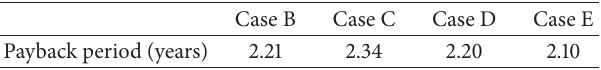
Table 3: Payback period for four different cases.